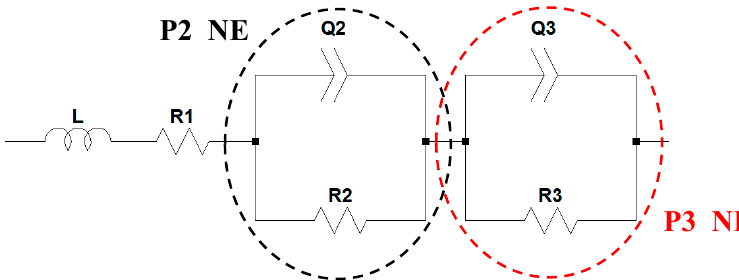
Figure 2. Electrical model employed to fit the impedance spectra of the negative electrode (NE) half-cell (graphite/Li).